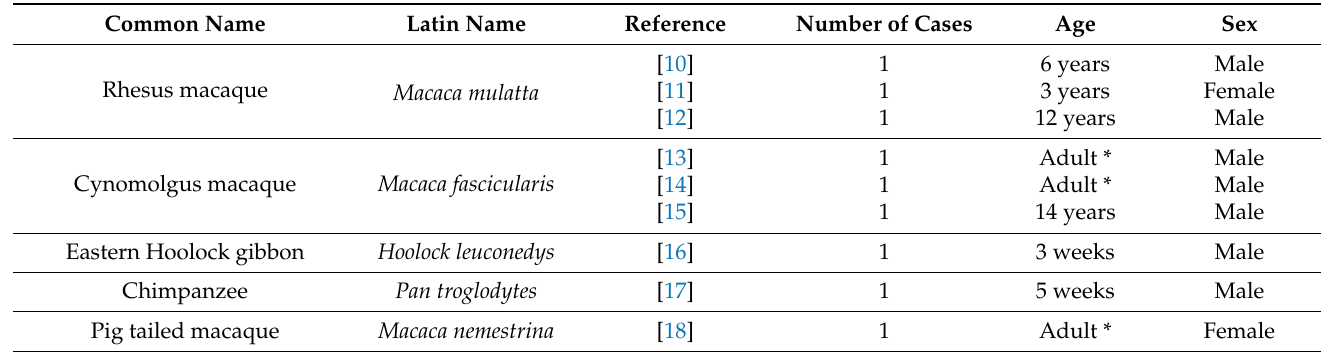
Table 1. Overview of the reported inguinal hernias in nonhuman primates. * Age of adult was not